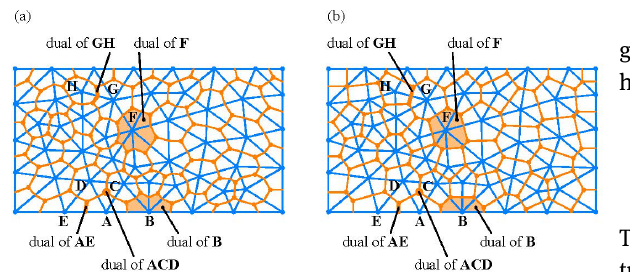
Figure 33: The barycentric dual mesh (a) and the dual mesh of Voronoi (b) in two-dimensional domains.